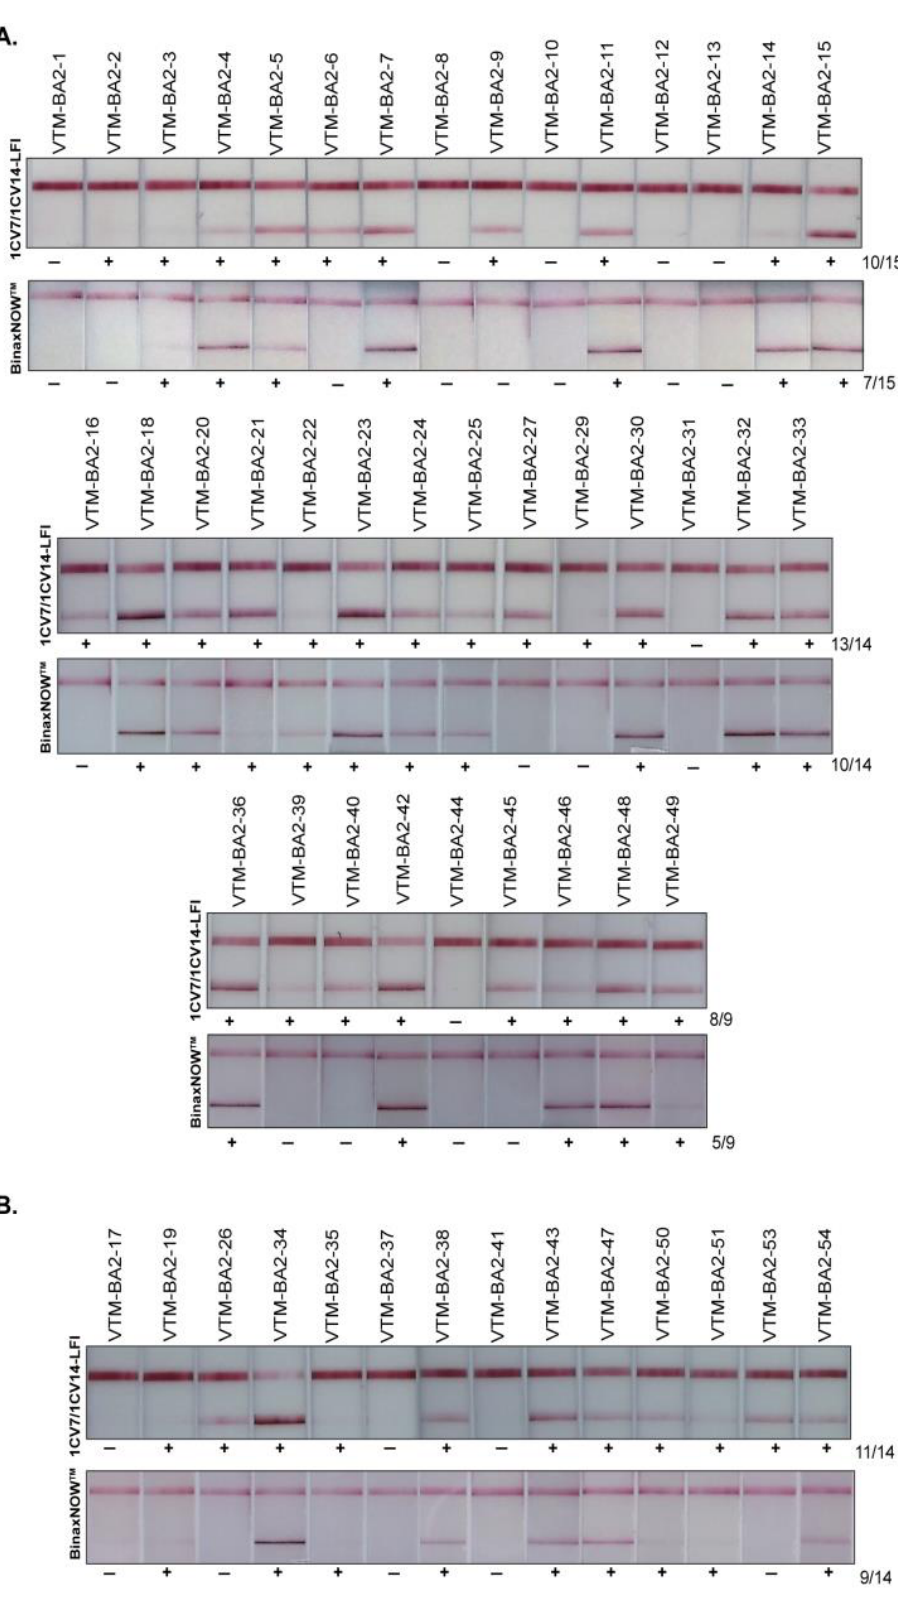
Figure 4. Sensitivities of 1CV7/1CV14 LFIs in comparison with BinaxNOW TM for the detection of Omicron BA.2 ( A ) and BA.2.12.1 ( B ).